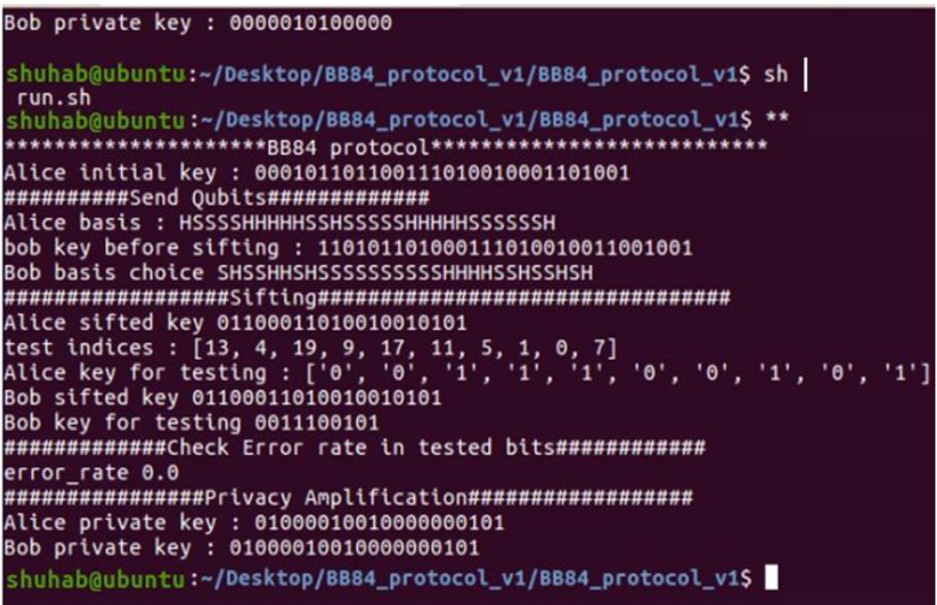
Figure 3. Execution of the proposed protocol.